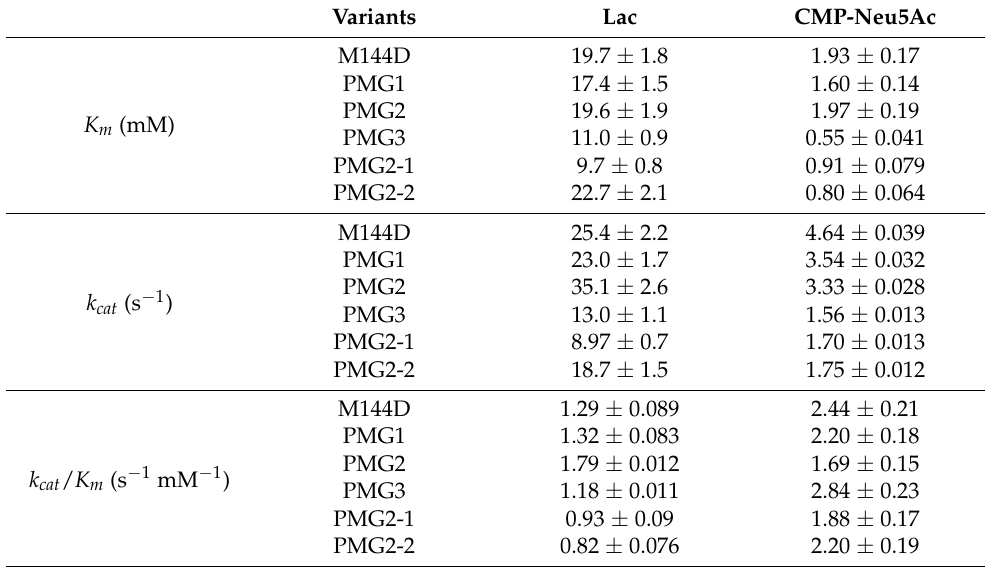
Table 3. Apparent kinetics of the α 2,3-sialyltransferase activities of M144D and mutants.